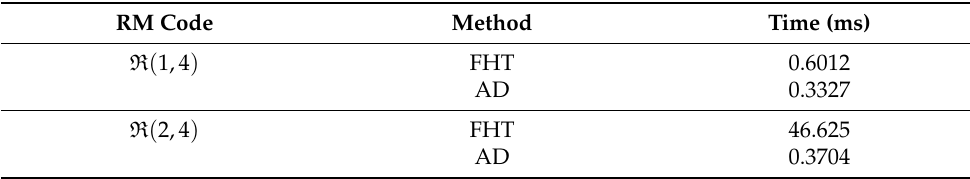
Table 5. Decoding time of RM code using FHT and